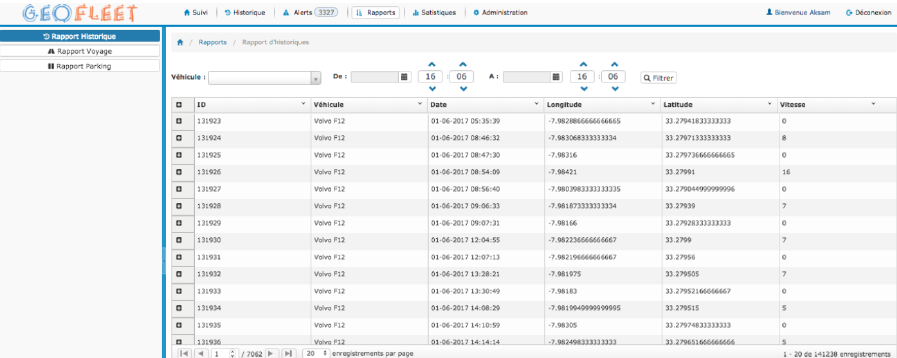
Figure 19. The nerve console showing the history reports of the system performance.